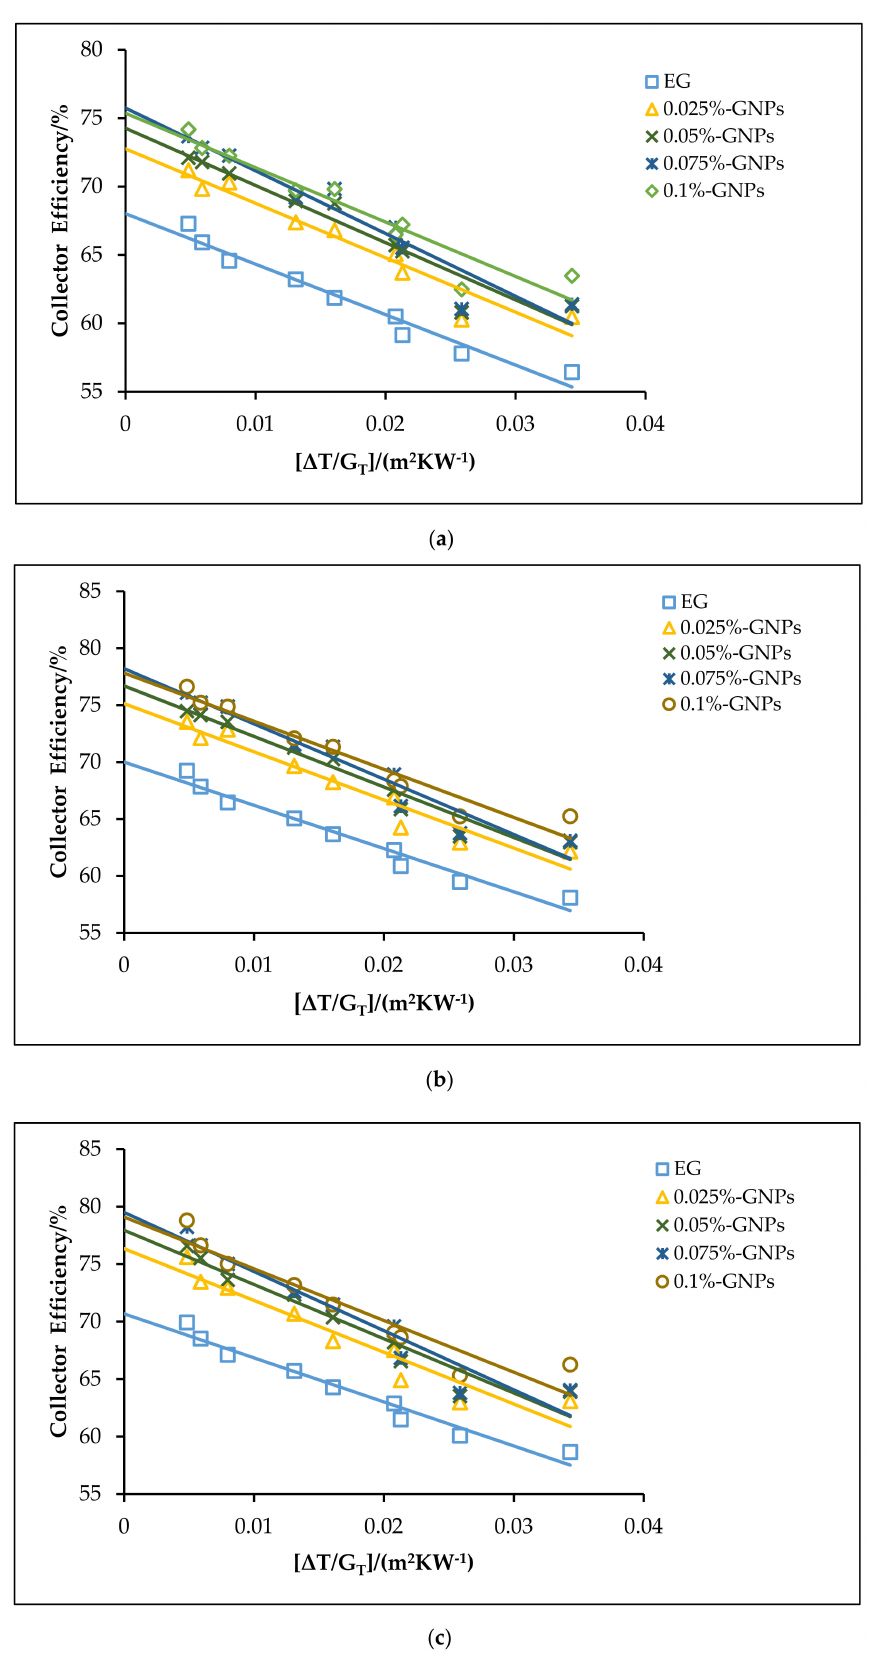
Figure 10. The theoretical efficiency for the f-GNPs–EG nanofluids with different weight concentra- tions: ( a ) 0.5 kg min − 1 ; ( b ) 1 kg min − 1 ; ( c ) 1.5 kg min − 1